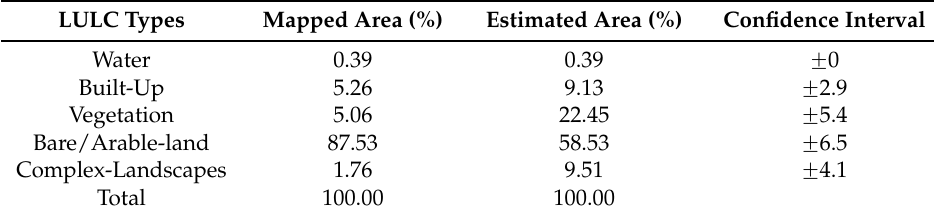
Table 7. Proportion of LULC category for 1986.